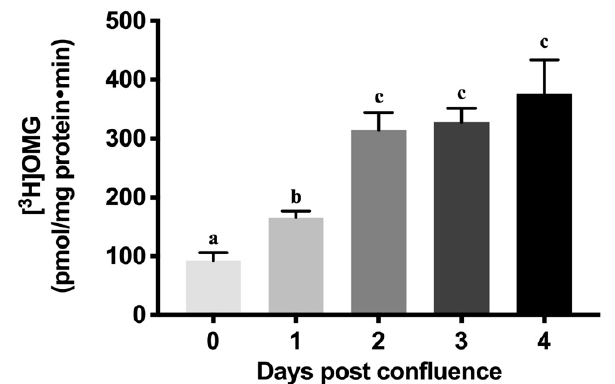
Figure 2. Increase in Na-dependent glucose uptake as IEC-18 cells matured. Uptake was performed in the presence and absence of phlorizin (1 mM) in reaction medium containing [ 3 H]-OMG tracer. Values are represented as means ± SEM, n = 6 independent experiments. Values not sharing common superscripted letters are significantly different at p < 0.001.